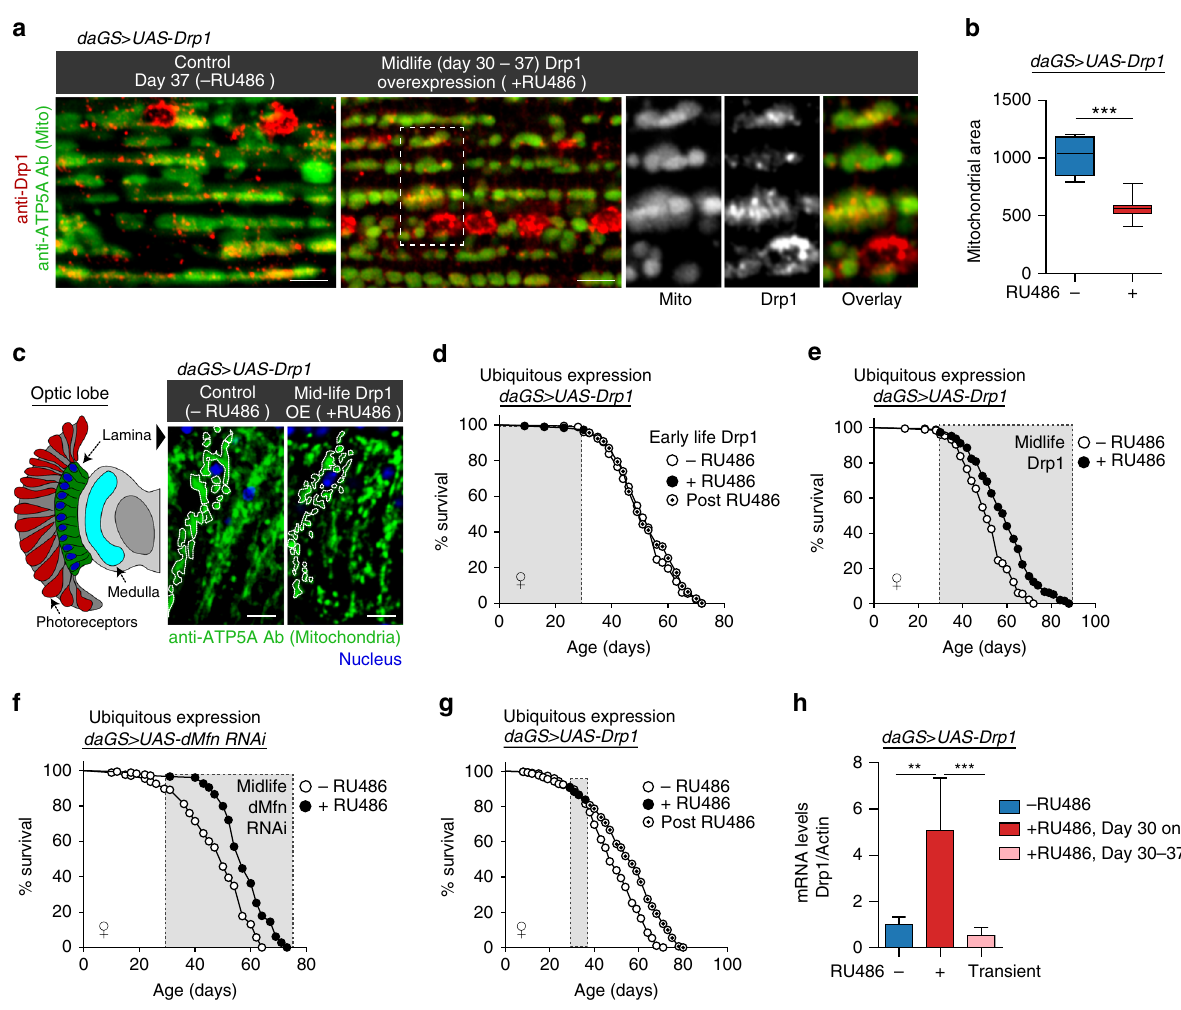
Fig. 1 Midlife Drp1 induction extends lifespan. a , b Immunostaining of indirect fl ight muscles a from 37 day old daGS > UAS-Drp1 females with or without RU486-mediated transgene induction for 7 days from day 30 to day 37, showing mitochondria ( green channel , anti-ATP5a) and Drp1 ( red channel , anti- Drp1). Scale bar is 5 µ m. Quanti fi cation of mitochondrial size b ; n = 7 individual thoraces; *** p < 0.001; two-tailed unpaired t -test. c Immunostaining of optic lobe/brain from 37 day old daGS > UAS-Drp1 females with or without RU486-mediated transgene induction for 7 days from day 30 to day 37, showing mitochondria ( green channel , anti-ATP5a) and nuclei ( blue channel , TO-PRO-3). Scale bar is 5 µ m. d Survival curves of daGS > UAS-Drp1 females with or without RU486-mediated transgene induction from day 1 to day 30. The shaded area indicates the duration of Drp1 induction. p = 0.42, log-rank test; n > 179 fl ies. e Survival curves of daGS > UAS-Drp1 females with or without RU486-mediated transgene induction from day 30 onwards. The shaded area indicates the duration of Drp1 induction. p < 0.0001, log-rank test; n > 179 fl ies. f Survival curves of daGS > UAS-dMfn-RNAi females with or without RU486- mediated transgene induction from day 30 onwards. The shaded area indicates the duration of dMfn RNAi. p < 0.0001, log-rank test; n > 175 fl ies. g Survival curves of daGS > UAS-Drp1 females with or without RU486-mediated transgene induction from day 30 to day 37. The shaded area indicates the duration